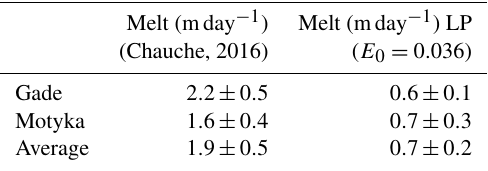
Figure 14. Three vertical melt rate profiles of the LP model (a) for three different entrainment coefficients E 0 for Helheim Glacier. With a discharge of 2 . 69 × 10 − 2 m 2 s − 1 and E 0 = 0 . 036 we obtain an average melt rate of m = 1 . 7ma − 1 close to Sutherland and Stra- neo (2012) (1.8mday − 1 ). Table 5. Comparison of the melt rate calculated with the LP model and the empirical data obtained with the Gade and Motyka model (Chauche, 2016).